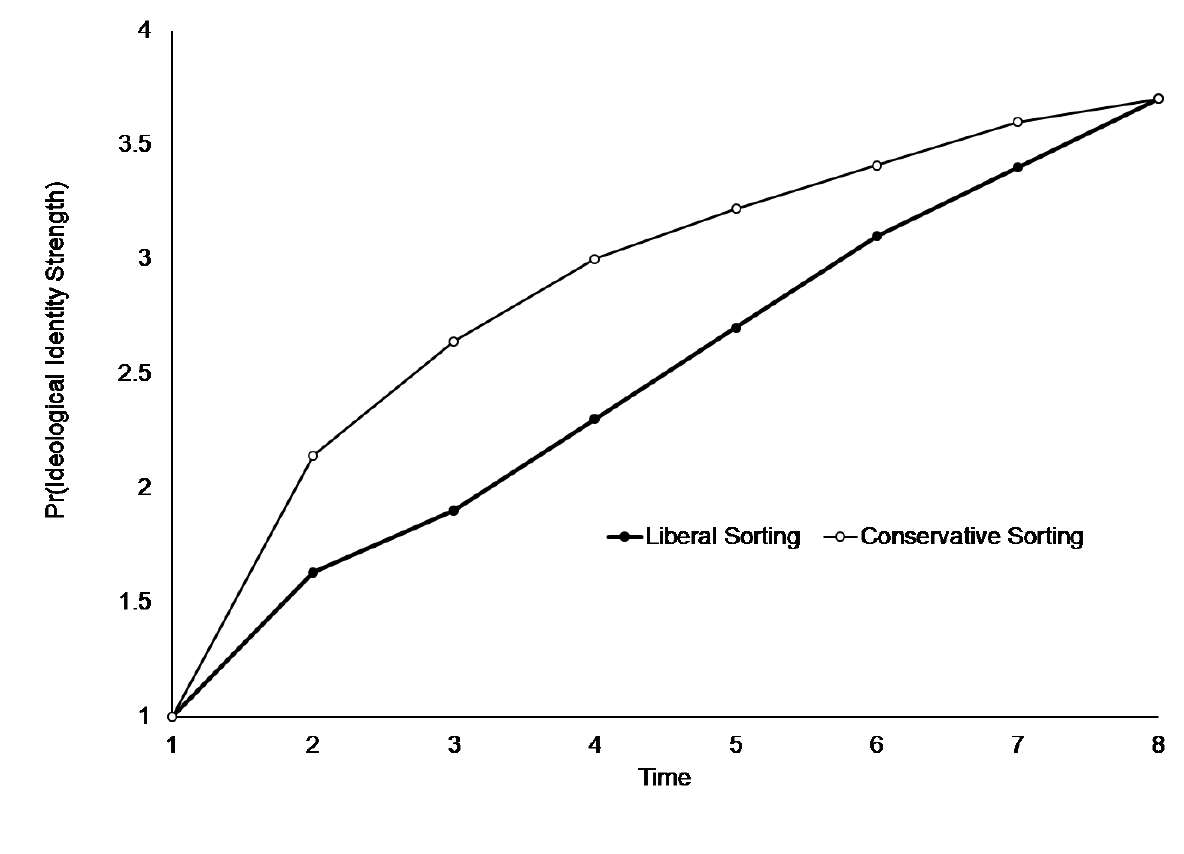
Figure 5: Predicted trajectories of ideological identity strength based on significant coefficients in reported models. Notes: All individuals start as moderates. Liberally sorted individuals have 10 or more trusted liberal ties and no trusted conservative ties. Conservatively sorted individuals have the inverse tie profile. Liberal sorting leads to an eight-point increase of ideological attitude alignment, whereas conservative sorting leads to a two-point increase at each